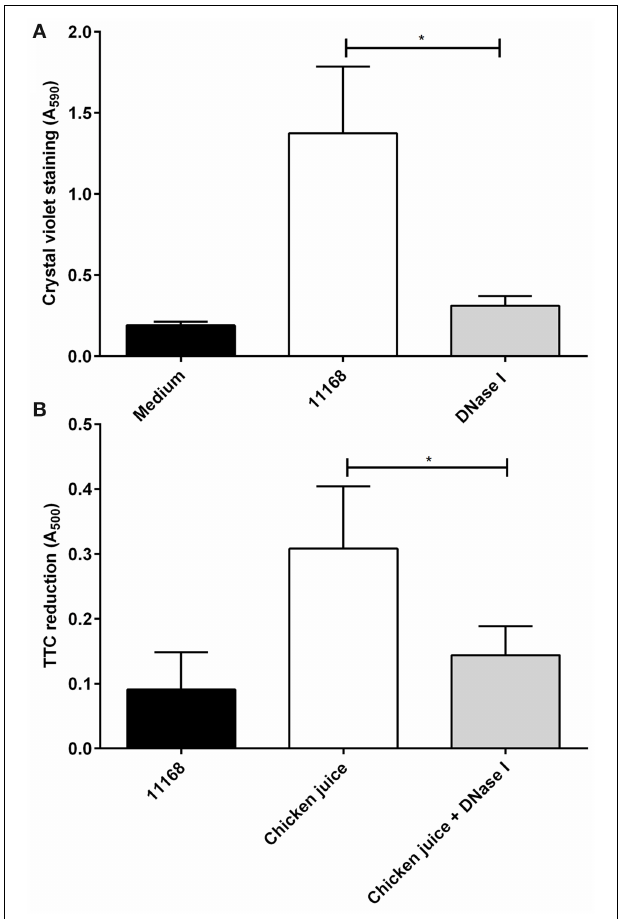
FIGURE 5 | DNase I treatment is effective against C. jejuni biofilms on stainless steel surfaces and in the presence of organic materials in aerobic conditions. The ability of DNase I to inhibit biofilm formation of C. jejuni NCTC 11168 on sterile, stainless steel coupons (A) or in the presence of chicken juice, mimicking a conditioned surface (B) . TTC staining was used to measure biofilm formation in the presence of chicken juice (B) . DNase I is able to significantly decrease biofilm formation in both conditions. Error bars show standard deviation. Statistically significant results, as determined using the Mann–Whitney U test, are indicated using an asterisk ( * P < 0 . 05 ).